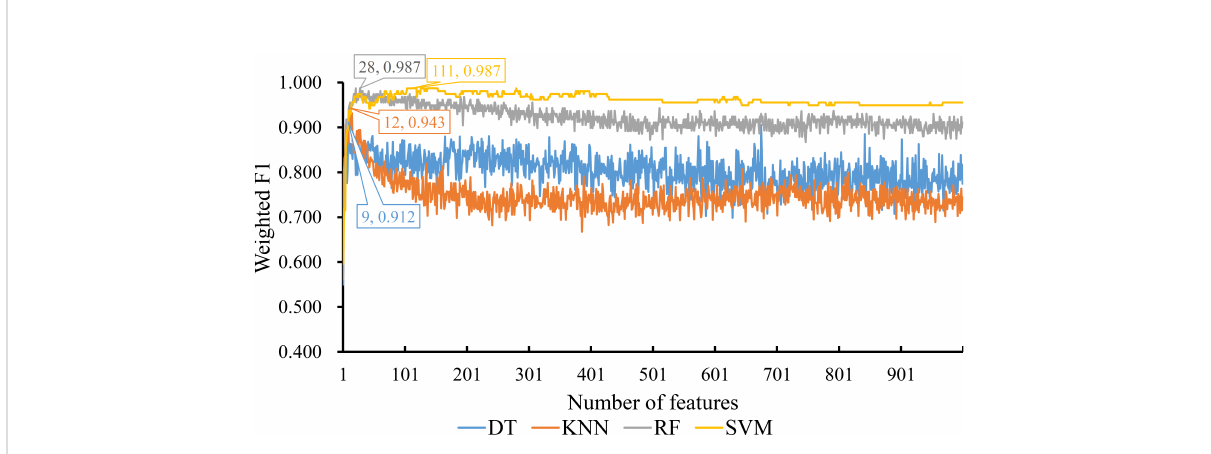
FIGURE 5 IFS curves for displaying the performance of four classi fi cation algorithms on the feature list yielded by LASSO method. The best classi fi ers on different algorithms yield the weight F1 values of 0.912, 0.943, 0.987 and 0.987, respectively, which use top 9, 12, 28 and 111, respectively, features in the list.